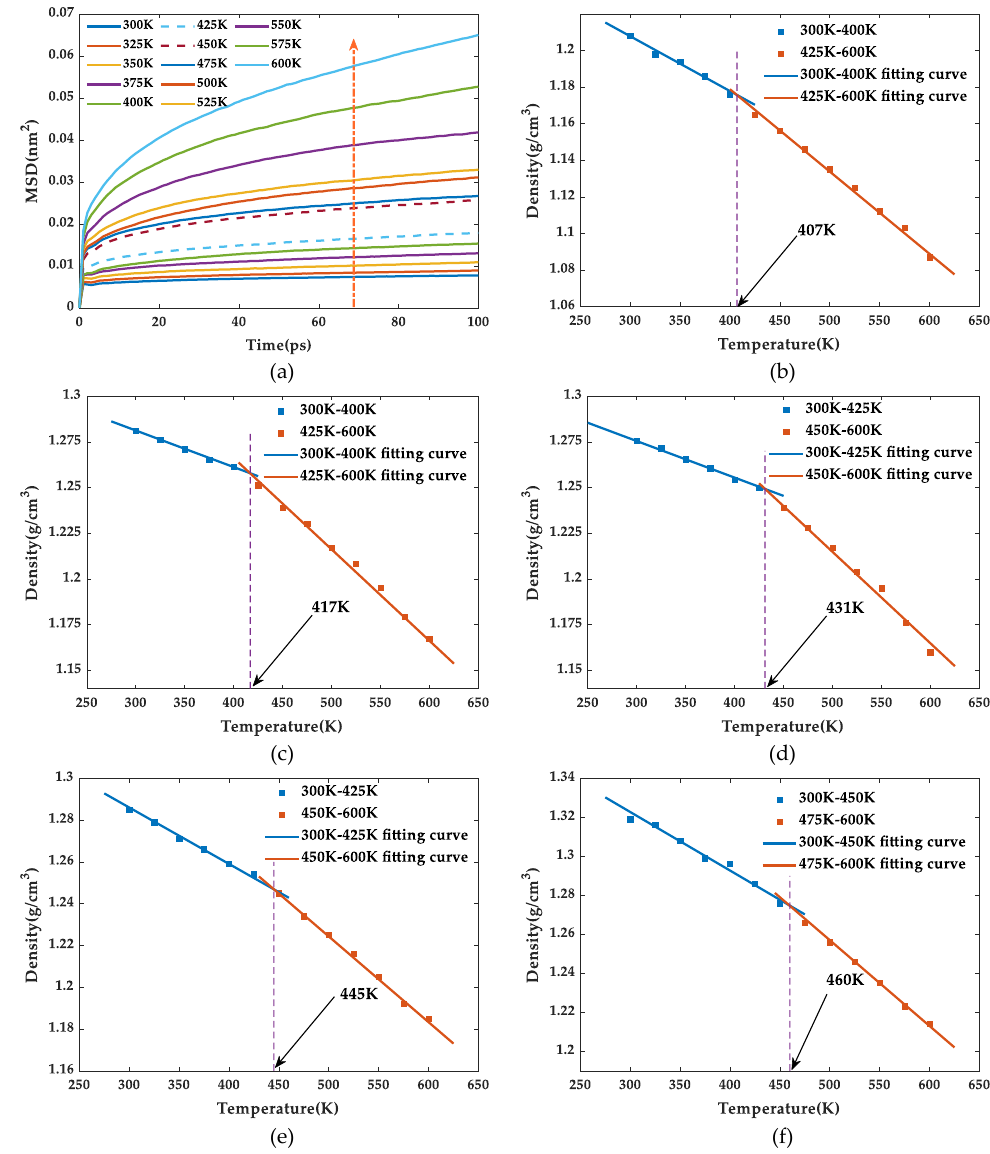
Figure 5. ( a ) The MSD–time curves of epoxy resins; ( b ) density curves versus temperature of pure EP; ( c ) density curves versus temperature of SiO 2 /EP; ( d ) density curves versus temperature of SiO 2 -KH560/EP; ( e ) density curves versus temperature of SiO 2 -HHBP/EP; ( f ) density curves versus temperature of SiO 2 -CHBP/EP. Table 1. T g (units: K) of